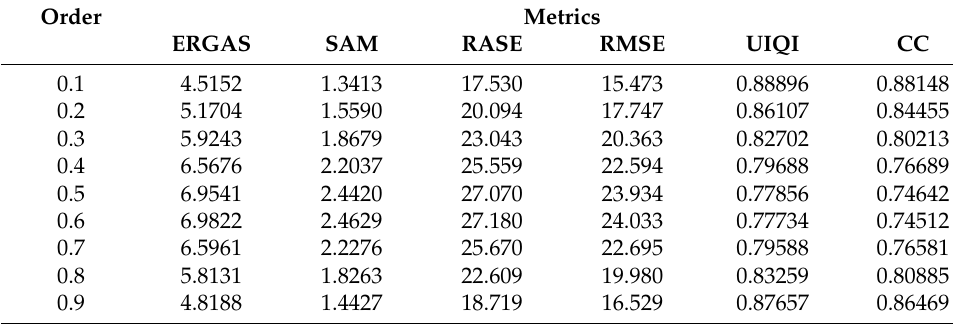
Table 3. Results for computing derivative using an incorrect mask proposed in [21].